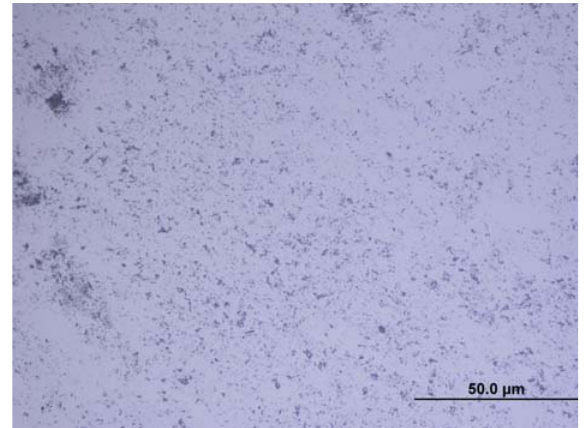
Figure 5- Pumice - small rounded